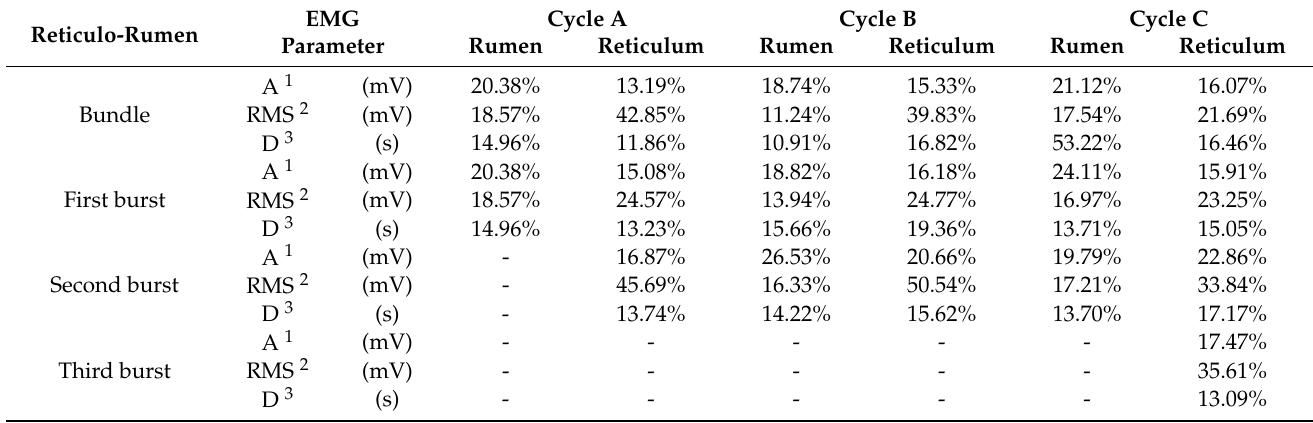
Table 3. The coefficient of variation (CV, %) for EMG signal parameters in the reticulo-rumen during cycles A, B, and C calculated throughout observations (5–6